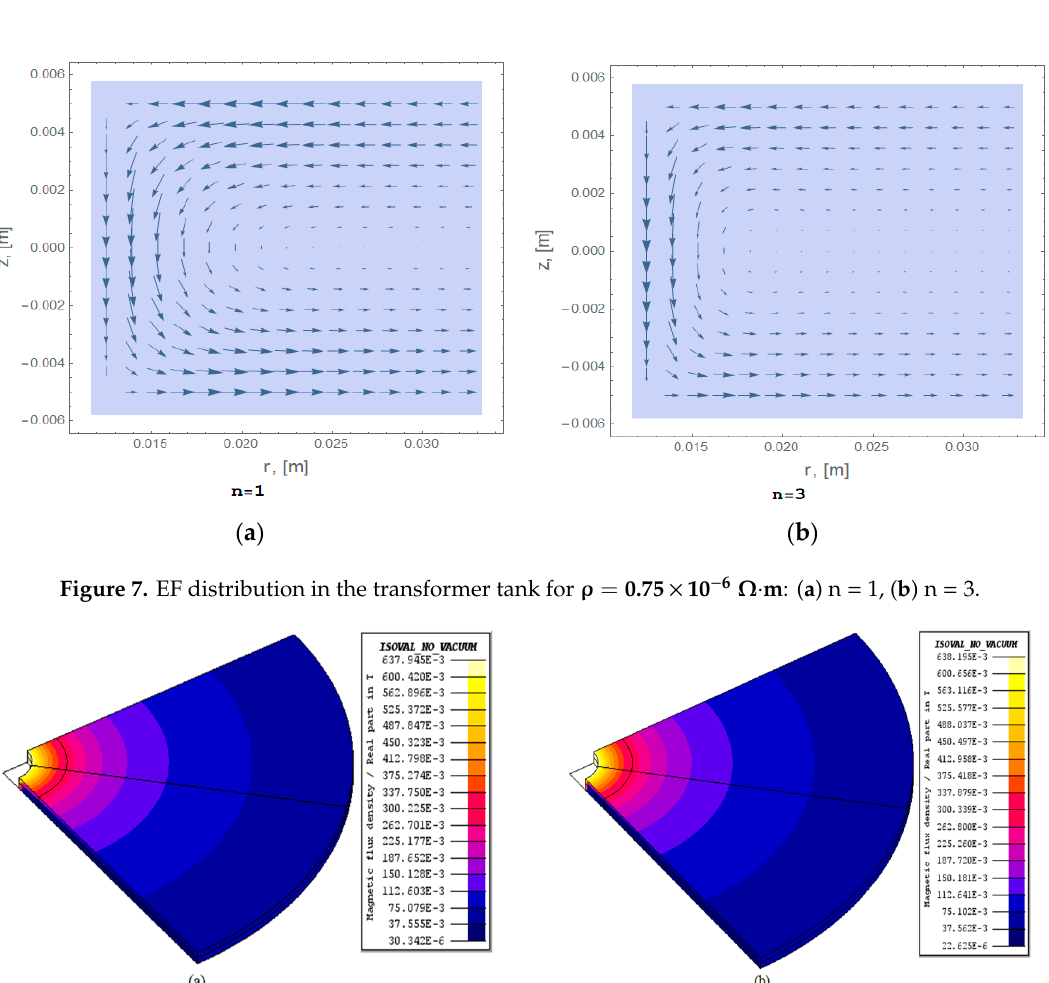
Figure 6. Electric field (EF) distribution in the transformer tank for (cid:2761) = (cid:2777). (cid:2779)(cid:2782) × (cid:2778)(cid:2777) (cid:2879)(cid:2783) (cid:2743) · (cid:1813) : ( a ) n = 1, ( b ) n = 3.